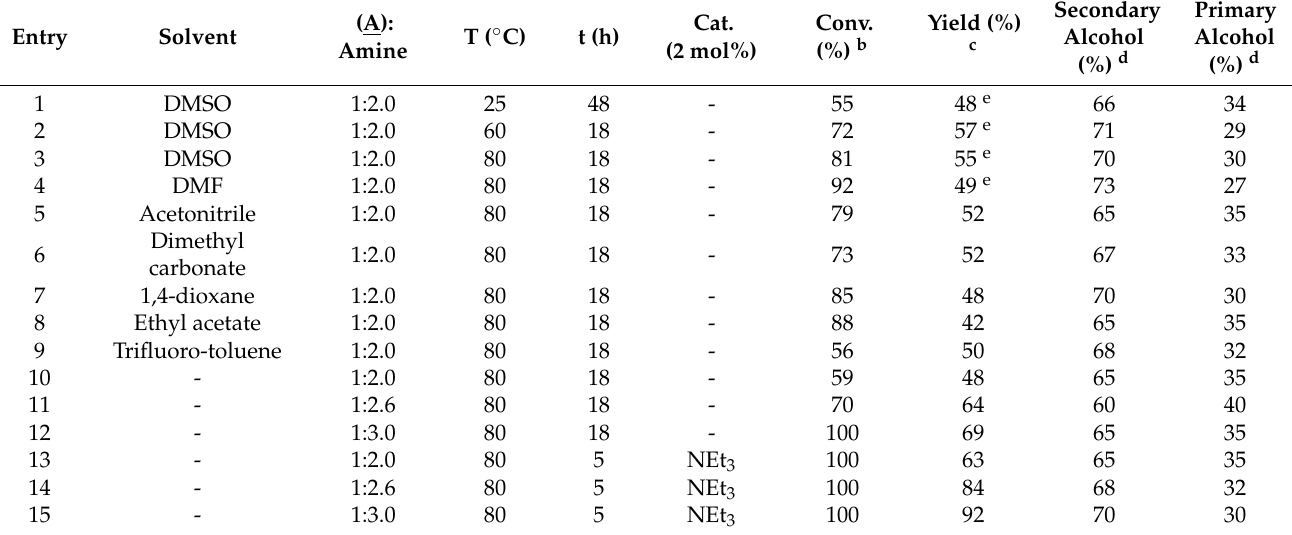
Table 2. Model reaction of ( A ) with hexylamine a : conditions